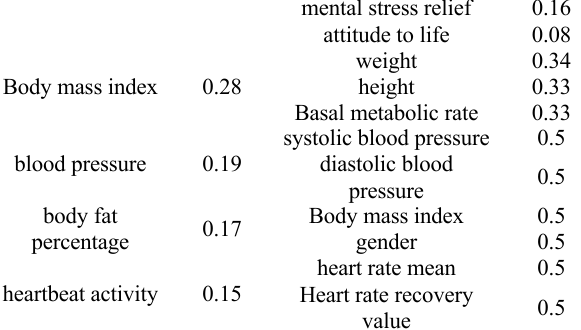
Figure 3. Collection results of physiological indicators of morbidly obese people